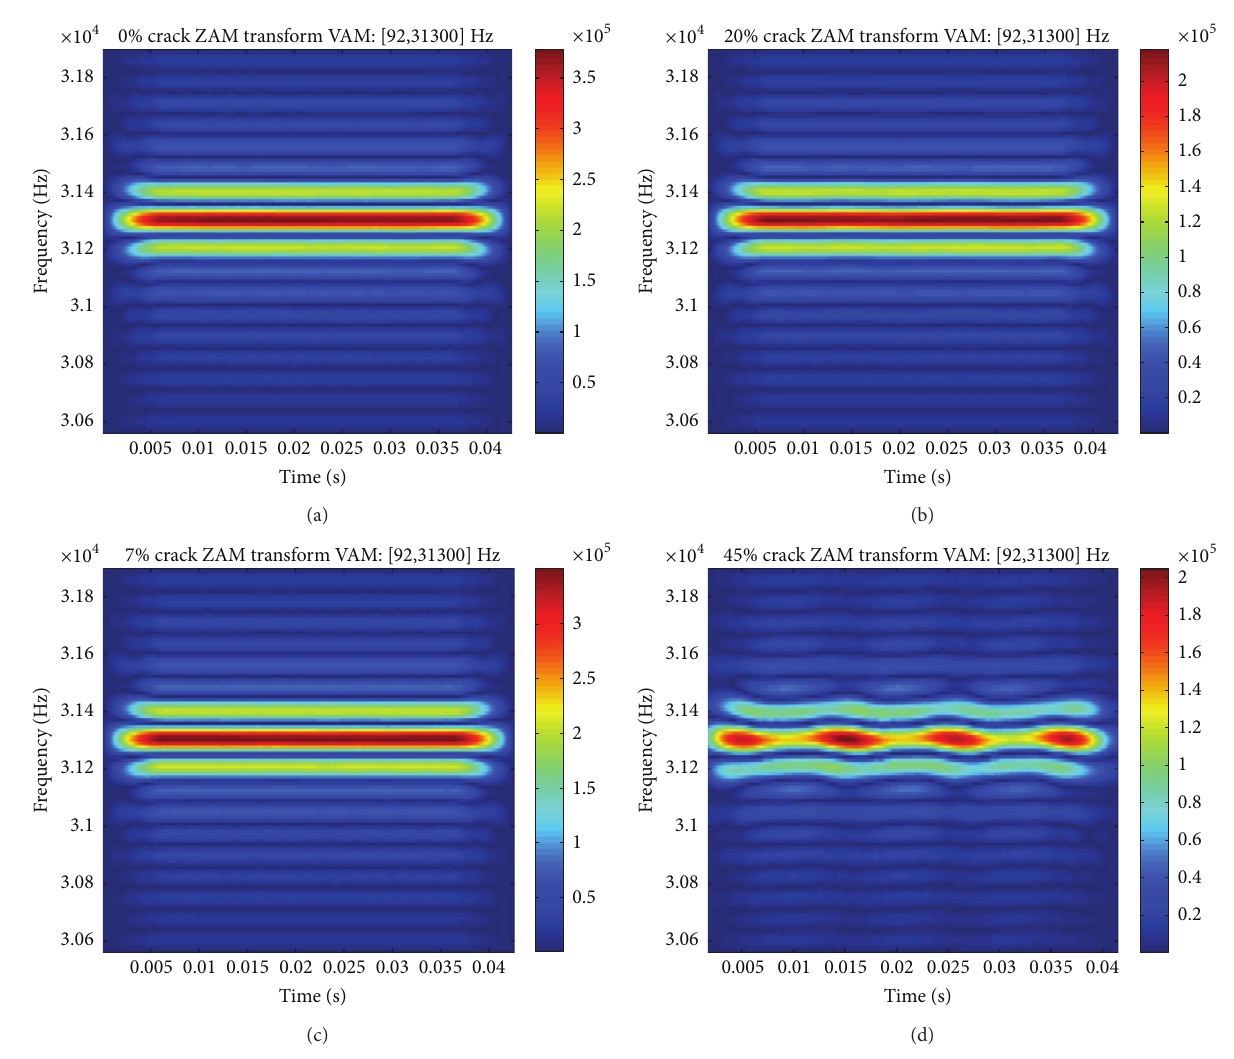
Figure 3: Results from the ZAM analysis of the experimental data of Figure 2 for 0% (a), 7% (c), 20% (b), and 45% (d) crack size,